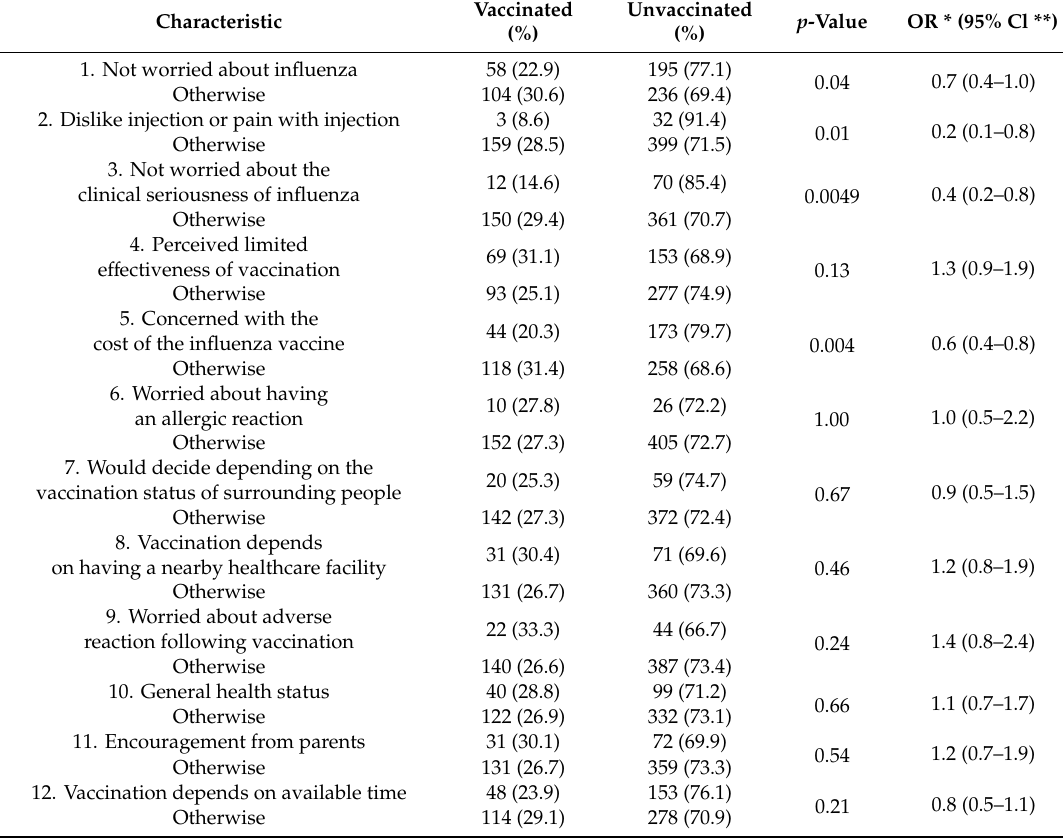
Table 5. Frequency of vaccination by participants’ attitudes toward influenza and